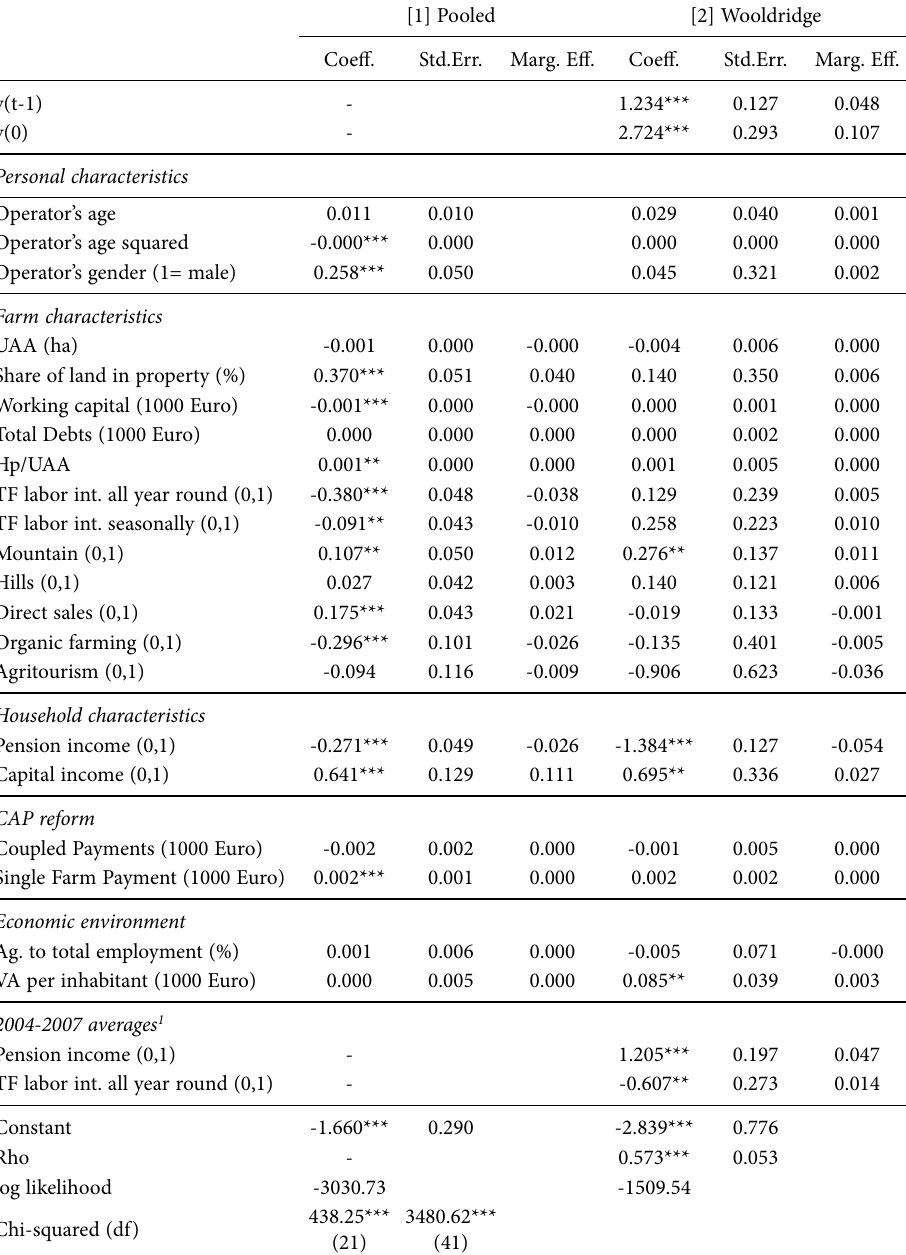
Table 2. Estimates of the models of off-farm labour